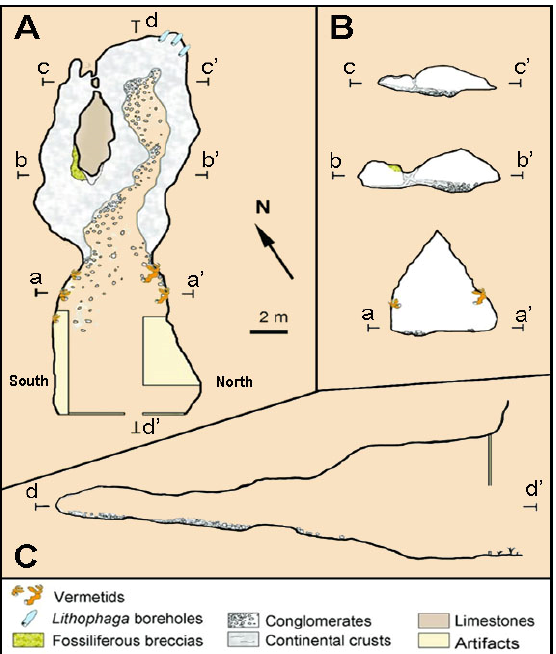
Figure 15. Map of the Taormina Cave. ( A ) Plan view with the indication of transversal (a-a’, b-b’ and c-c’) and longitudinal (d-d’) sections, reported in ( B , C ), respectively (from Ref. [61], modified).